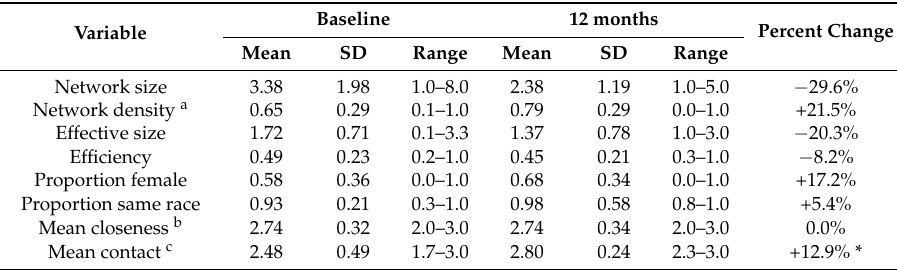
Table 2. Characteristics of participants’ networks changes between baseline and 12 months (N =